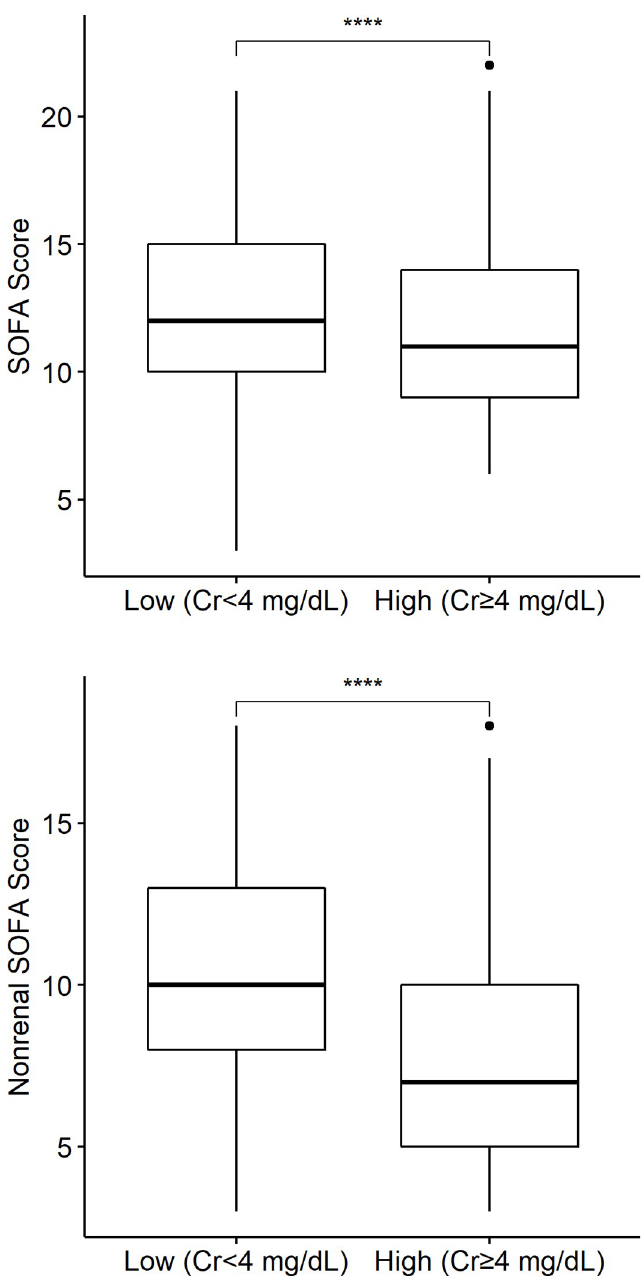
Fig 3. Box plots of SOFA and nonrenal SOFA scores between the low-creatinine (Cr < 4 mg/dL) group and with high-creatinine (Cr � 4 mg/dL) group. The low-creatinine (Cr < 4 mg/dL) group had higher SOFA and nonrenal SOFA scores ( Kruskal –Wallis test, P <